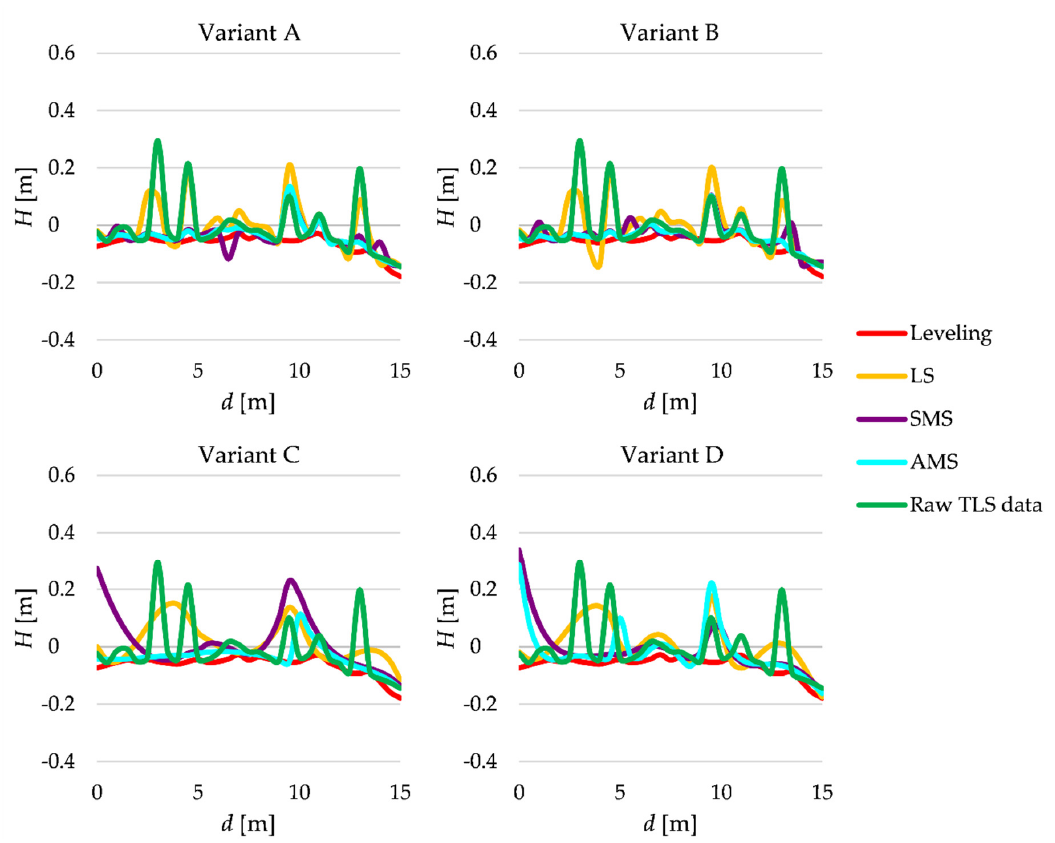
Figure 8. Estimated terrain profiles of line I.